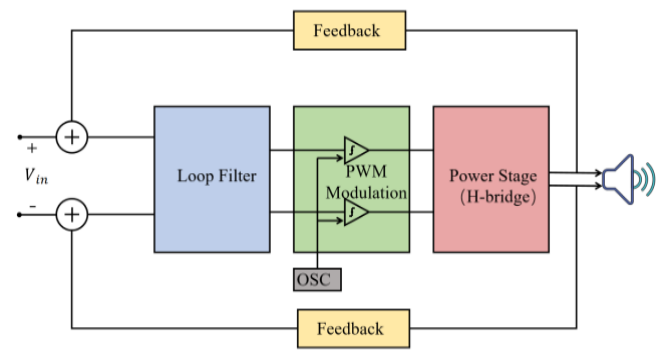
Figure 17. Typical filterless Class D PWM design [Error! Reference source not found].